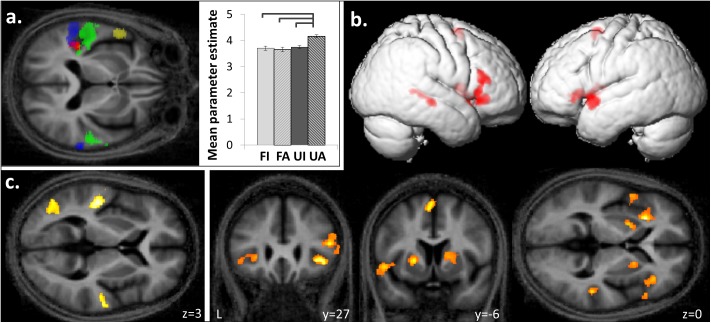
Functional segregation within planum temporale and superior temporal gyrus based on temporal structure and familiarity of melodies. (a) Posterior superior temporal gyrus and planum temporale bilaterally were activated by anisochronous compared to isochronous melodies ([FI + UI] < [FA + UA], blue) and by unfamiliar compared to familiar melodies ([FI + FA] < [UI + UA], green). An interaction between the familiarity and temporal structure factors was observed in left medial planum temporale ([FI < FA] < [UI < UA]; red) and the group mean cluster beta parameter estimates plots (±1 SD for timing) show a greater response to unfamiliar-anisochronous melodies (UA) than the other three conditions (significant p < 0.05). Left anterior temporal lobe showed more activation to familiar than unfamiliar melodies ([FI + FA] > [UI + UA], yellow). (b) Familiar melodies also preferentially activated right superior temporal sulcus, and bilateral inferior frontal gyri, insula, putamen, and SMA ([FI + FA] > [UI + UA]). (c) Unfamiliar compared to familiar melodies activated the left lateral occipito-temporal cortex in addition to the bilateral temporal gyri ([FI + FA] < [UI + UA]). Significant clusters (cluster pFWE < 0.05, voxel punc < 0.001) are displayed on the group mean MT map normalized to a group template brain image in MNI space. In figure only, the transverse MNI section is pitched –0.5 radians to better visualize activation along the superior temporal gyri.